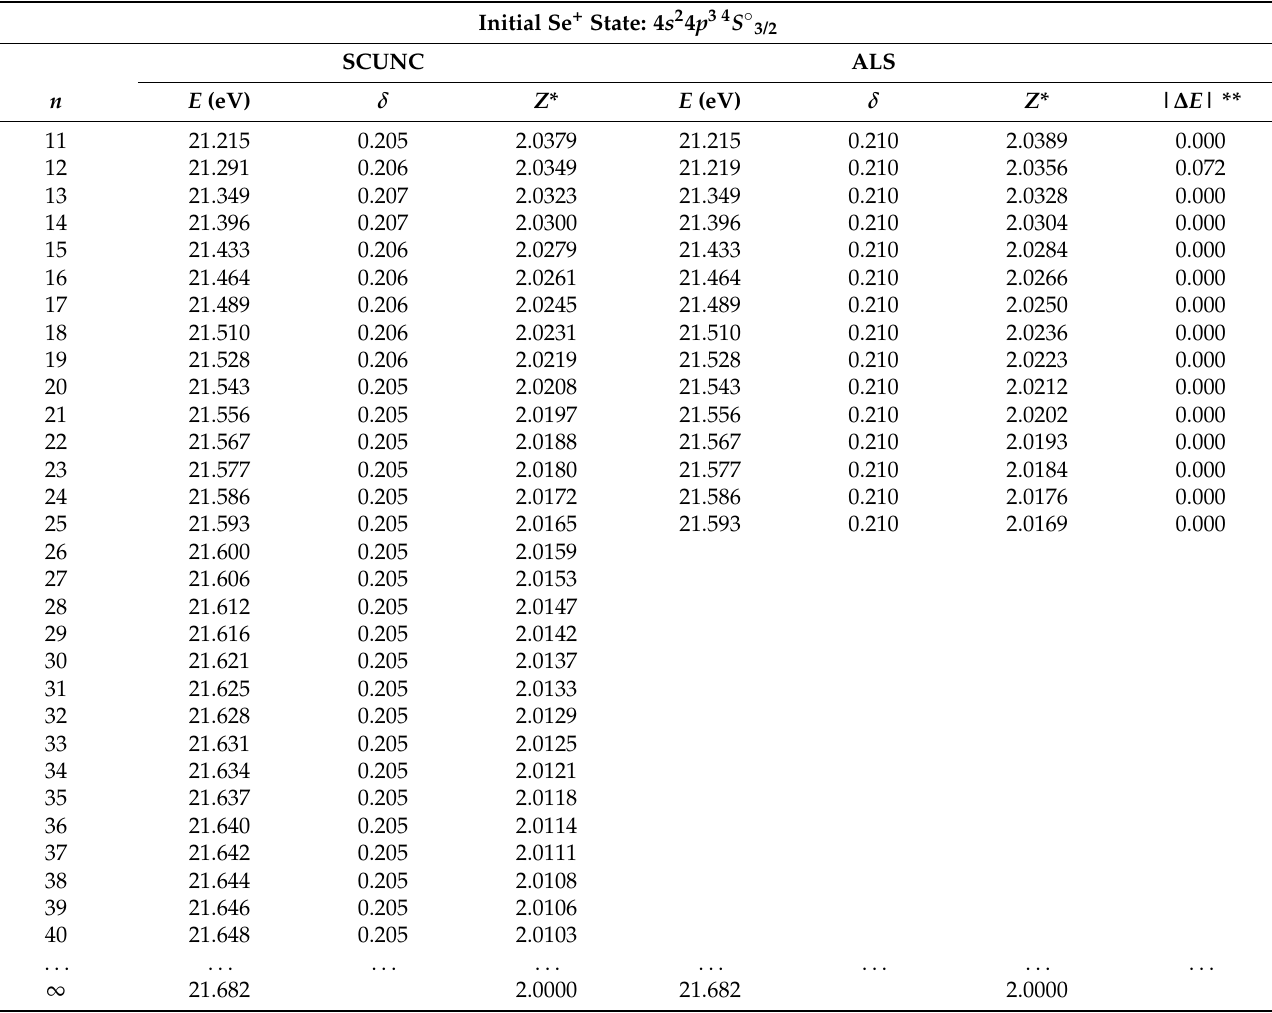
Table 12. Energy resonances ( E ), quantum defect ( δ ) and effective charge ( Z *) of the 4 s 2 4 p 2 ( 3 P 2 ) nd Rydberg series originating from the 4 s 2 4 p 3 4 S ◦ 3/2 ground state of Se + converging to the 3 P 2 series limit in Se 2+ . The present results (SCUNC) are compared with the experimental data from ALS measurements [6]. f 1 ( 3 P 2 ; 4 S ◦ 3/2 ) = − 0.379 ± 0.042 with ν =